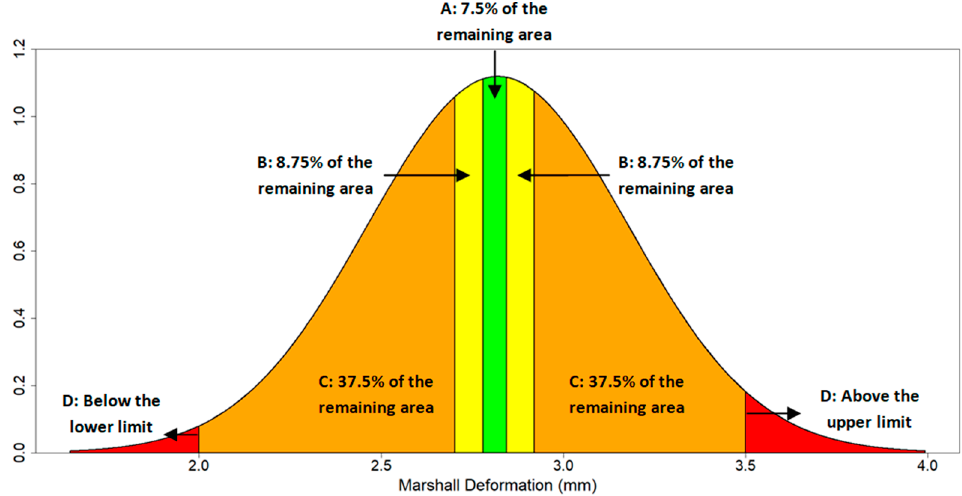
Figure 7. Probability density function of Marshall deformation.